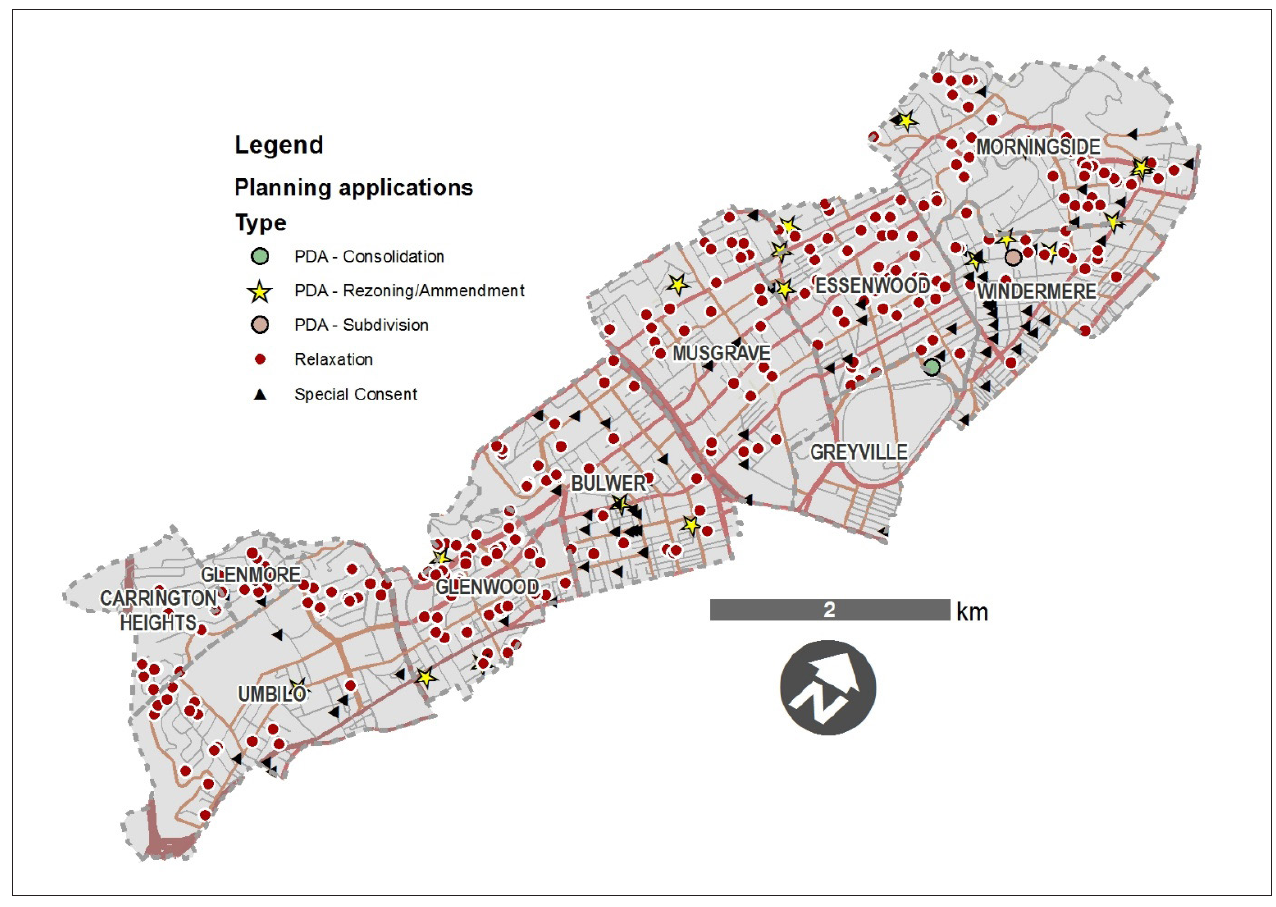
Figure 6: Distribution of the type of planning applications on the Berea 2012-2016 Source: Adapted from eThekwini Municipality Central Durban Application Register by DUT GIS Unit,